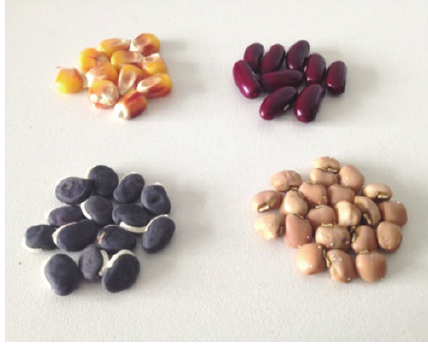
Figure 1: Seed of 4 species used in the experiment.